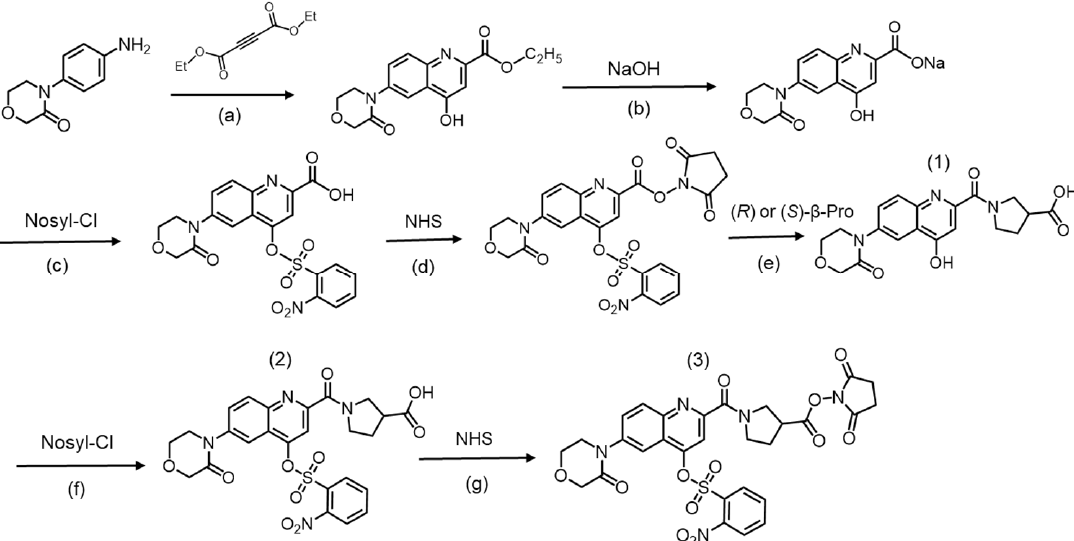
Figure 8. Synthetic route of Ns-MOK- β -Pro-OSu from 4-(3-oxomorpholino)aniline. ( a ) i: MeOH 80 ◦ C 4 h, ii: Ph 2 O 220 ◦ C 2 h; ( b ) MeOH/H 2 O r.t. 12 h, ( c ) NaHCO 3 r.t. 2 h, ( d ) 1-(3-dimethylaminopropyl)-3-ethylcarbodiimide hydrochloride (EDC) in CH 3 CN r.t. 2 h, ( e ) DMF, NaHCO 3 in H 2 O r.t. 2 h, ( f ) NaHCO 3 r.t. 2 h, and ( g ) EDC in CH 3 CN r.t. 2 h; ( 1 ) 1-(4-hydroxy-6-(3-oxomorpho- lino)quinoline-2-carbonyl)pyrrolidine-3-carboxylic acid; ( 2 ) 1-(4-(((2-nitrophenyl)sulfonyl)oxy)-6- (3-oxomorpholino)quinoline-2-carbonyl)pyrrolidine-3-carboxylic acid; ( 3 ) Ns-MOK- β -Pro-OSu.